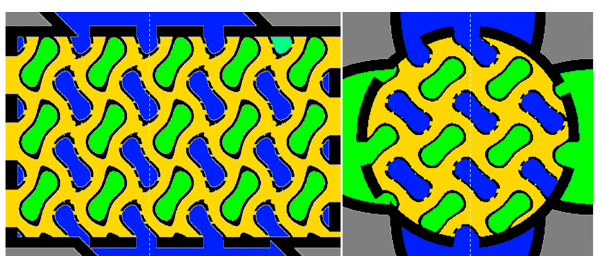
Figure 2. 2D sections of the reactor component to visualize the interconnected domain structure of fluid domains A (green), B (blue), and C (yellow). White-dashed lines label the position of the sections.